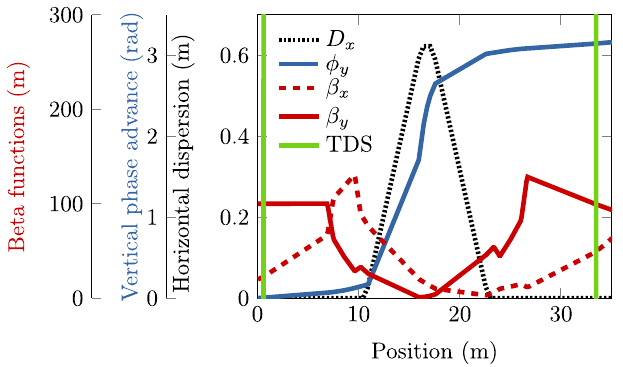
FIG. 2. Relevant accelerator optics (Twiss parameters) and positions of the transverse deflecting rf structures used to numerically demonstrate the reversible beam heater